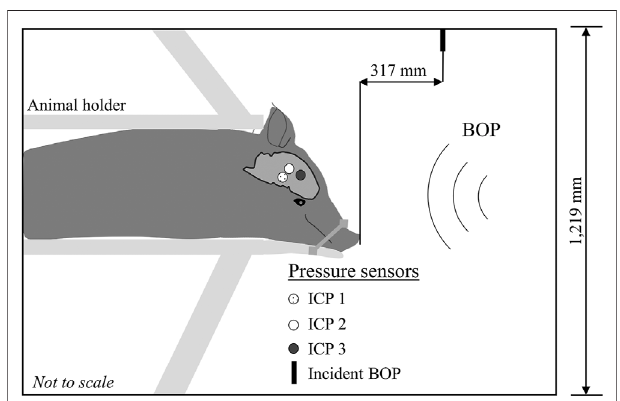
FIGURE 1 | Schematic representation of the experimental setup. We conducted all the experiments in an Advanced Blast Simulator with a 1,219- mm square cross-section. We secured the minipig in a holder with the animal in the prone position and facing the incident blast overpressure (BOP). Tominimizeheadmotionduringtheexperiments, wesecuredthesnouttothe holder with a cloth. We instrumented the animal with three pressure sensors implanted in the right hemisphere of the brain: the fi rst sensor [Intracranial pressure 1 (ICP 1)] was deep and central, close to the mid-coronal plane; the second sensor (ICP 2) was super fi cially inserted in a ventricle near the mid- coronal plane; and the third sensor (ICP 3) was in the temporal lobe near the sphenoid. We measured the incident BOP 317 mm in front of the animal (Incident